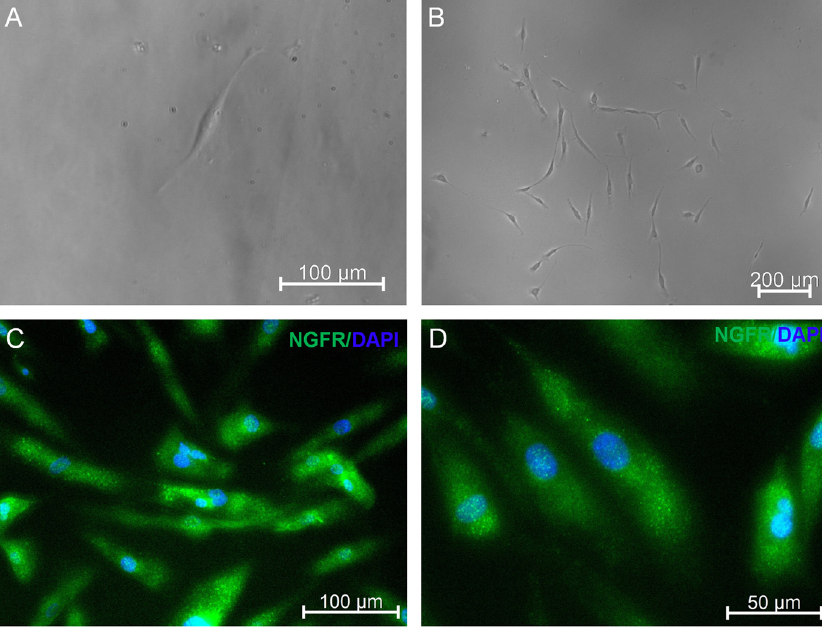
Fig 5. Neuronal differentiation of clonal derived EOM-MSC. (A) Microscopic image of single cell after 24hr of plating to isolate single cell derived colonies. (B) Single cell derived colony 7 days after plating. (C, D) Neuronal differentiation of single cell derived clones of EOM-MSC was determined by staining with NGFR 14 days after neuronal induction Representative microscopic images are